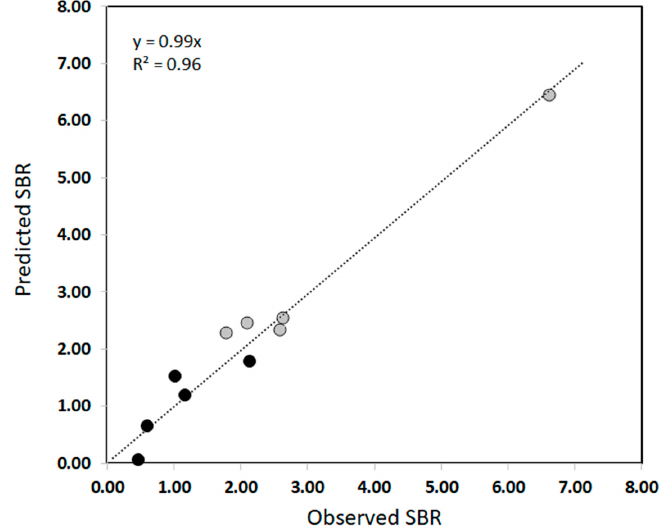
Figure 11. Scatter plot of observed and predicted solids / bitumen (SBR). Black circles = samples with dark froth; grey circles = samples with brown froth. Minerals 2020 , 10 , x FOR PEER REVIEW